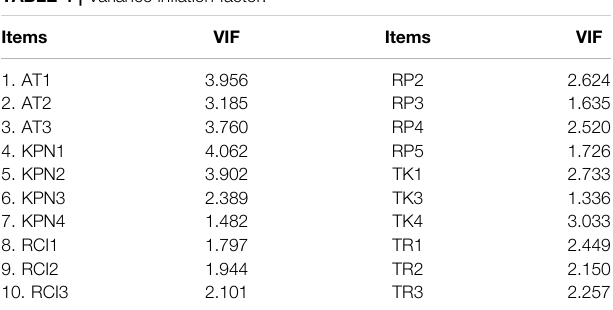
TABLE 4 | Variance in fl ation factor.